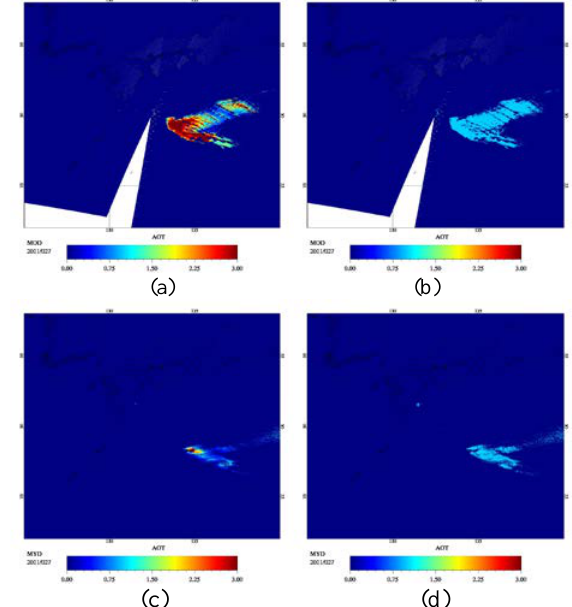
Figure 8. Volcanic ash plume height (left) and effective radius (right) for Terra (top) and Aqua (bottom) MODIS for the Shinmoedake volcanic eruption on 27 January 2011. Image boundary is rectangular region of latitude 22°N –38°N and longitude 125°E –